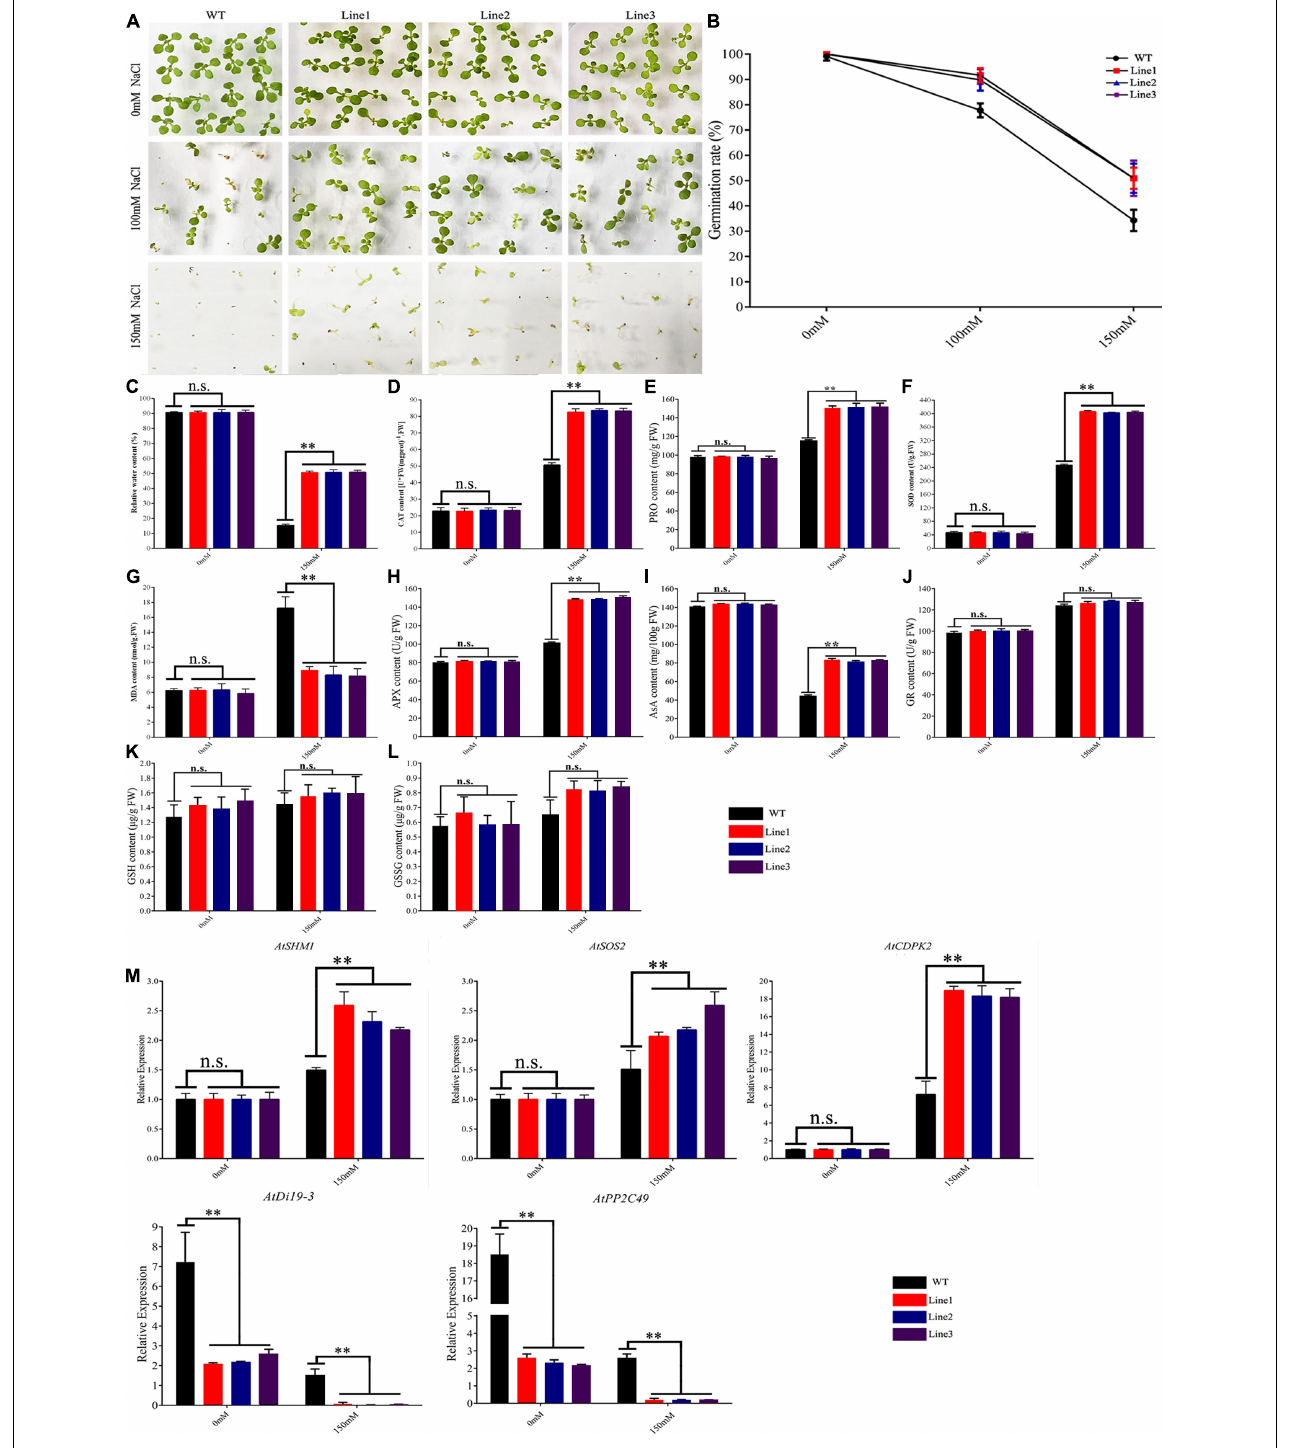
FIGURE 4 | Germination phenotypes of TaVQ14 in transgenic Arabidopsis plants under salt stress. (A) Germination performance in TaVQ14 -overexpressing and wild-type (WT) seeds grown on Murashige and Skoog medium containing 0, 100, or 150 mM of NaCl. (B) Rate of germination in transgenic and WT seeds. (C–L) Relative water content (C) and levels of catalase (D) , proline (E) , superoxide dismutase (F) , malondialdehyde (G) , Ascorbate Peroxidase (H) , Ascorbic acid (I) , Glutathion Reductases (J) , L-Glutathione (K) , and L-Glutathione oxidized (L) in transgenic and WT plants after salt treatment. Values are means ± SE ( n = 3). ∗ P < 0.05 ∗∗ P < 0.01 ( t -test). (M) Relative expression levels of salt-responsive genes in transgenic A. thaliana plants under normal salinity. Leaves of transgenic and WT plants were collected after salt stress. Y-axis: relative expression levels; X-axis: the time course of stress treatments; Error bars, 6 ± SE.